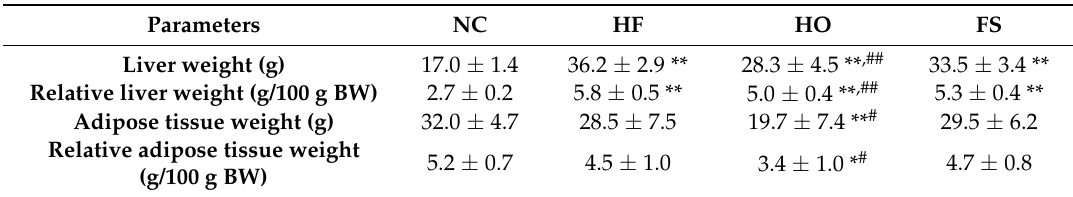
Table 3. The changes of liver and adipose tissue weights in HF-diet-fed rats supplemented with or without orlistat and RMD for 8 weeks.